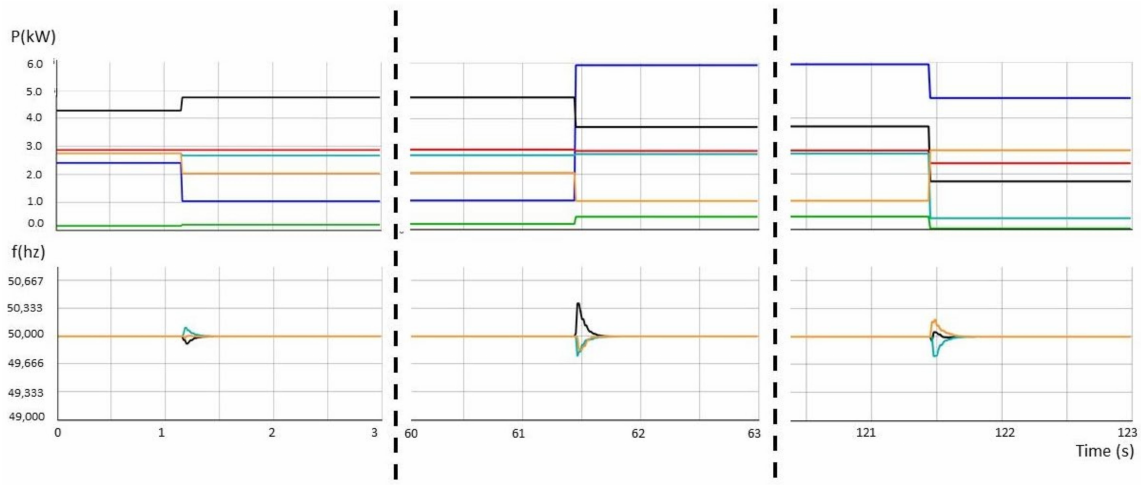
Figure 9. Network node’s frequency and power generator